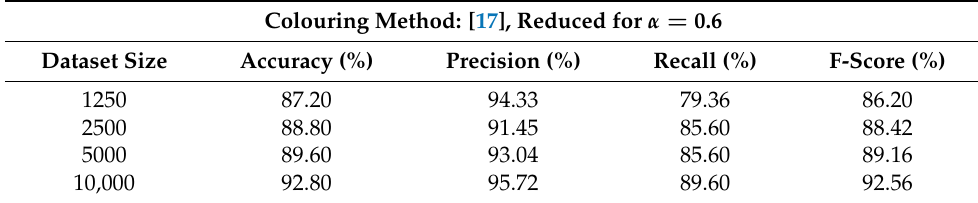
Table 7. Performance metrics for [17], processed with α = 0.6. Colouring Method: [17], Reduced for α = 0.6